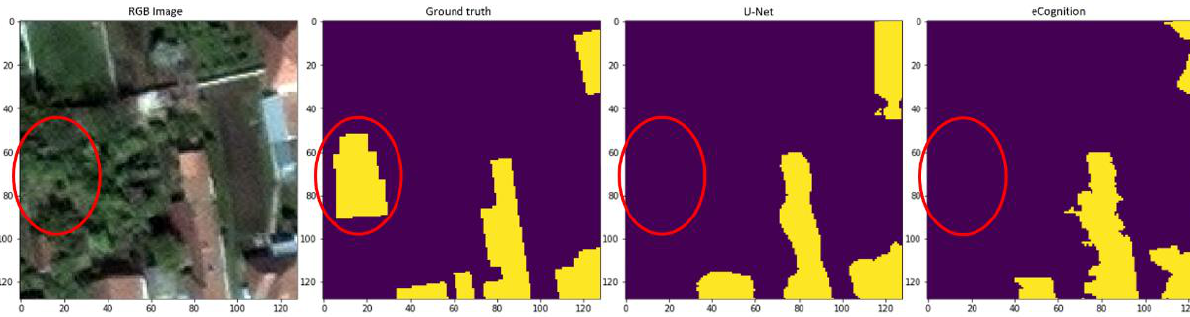
Figure 22. Correctly identified objects that were not in the training set—Zrenjanin.